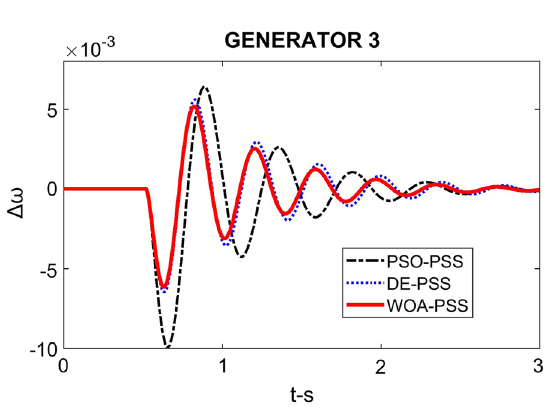
Fig. 9 Speed deviation of G3 for 10% step change at Vref